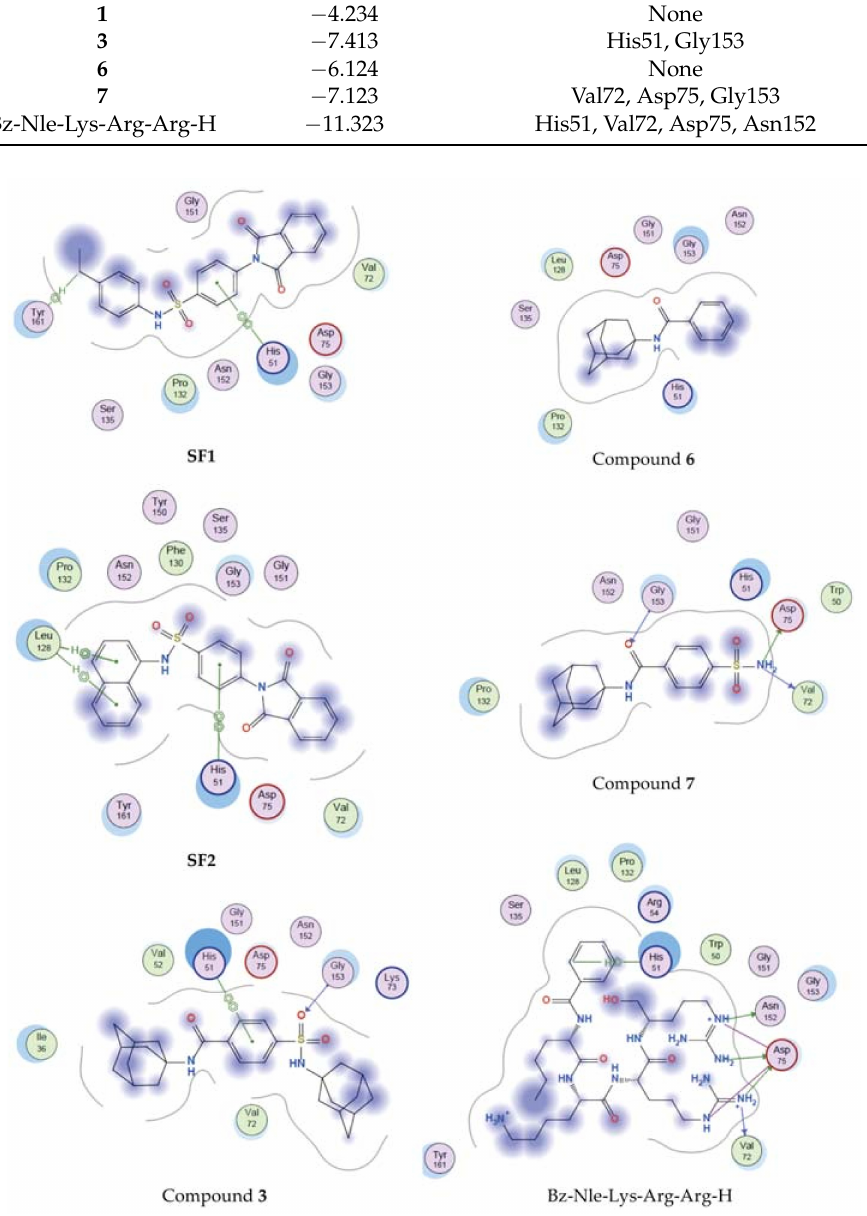
Figure 4. Binding interactions of reference compounds SF1 and SF2 , test compounds 3 , 6 , and 7 , and the known substrate inhibitor Bz-Nle-Lys-Arg-Arg-H with the active site of DENV2 NS2B/NS3 protease. Docking results indicated that as expected the known DENV2 NS2B/NS3 protease inhibitors, SF1 and SF2 , were able to form interactions with or are in close proximity to vital residues in the active site of DENV2 NS2B/NS3 protease with binding affinities of − 7.835 kcal/mol and − 8.011 kcal/mol, respectively. The substrate based inhibitor Bz-Nle-Lys-Arg-Arg-H also showed Compound 6 produced a low binding affinity ( − 6.124 kcal/mol) and lacked interactions with the